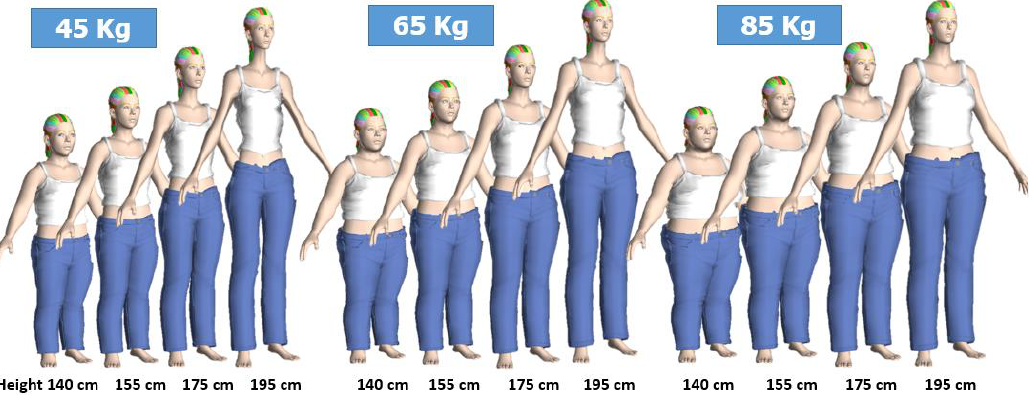
Figure 1. 3D body simulation for non-pregnant females using Morphing Technique.